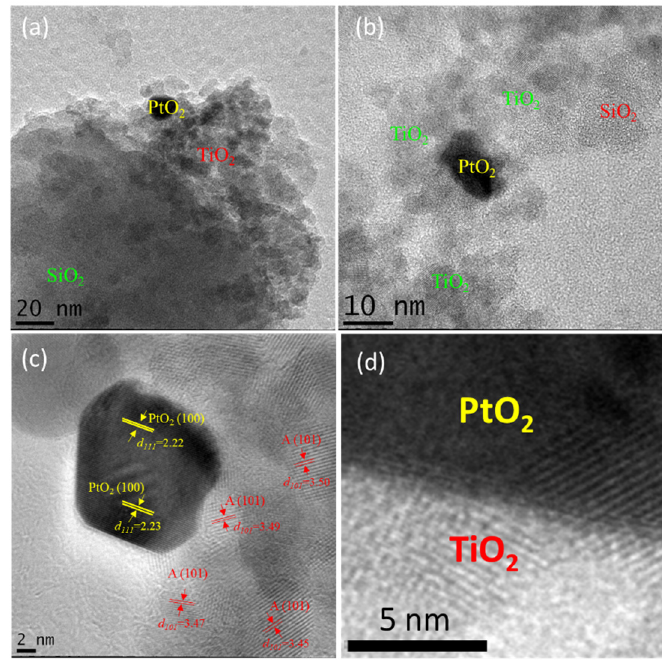
Figure 5. TEM and HRTEM images of 0.25%Pt-TiO 2 /SiO 2 .